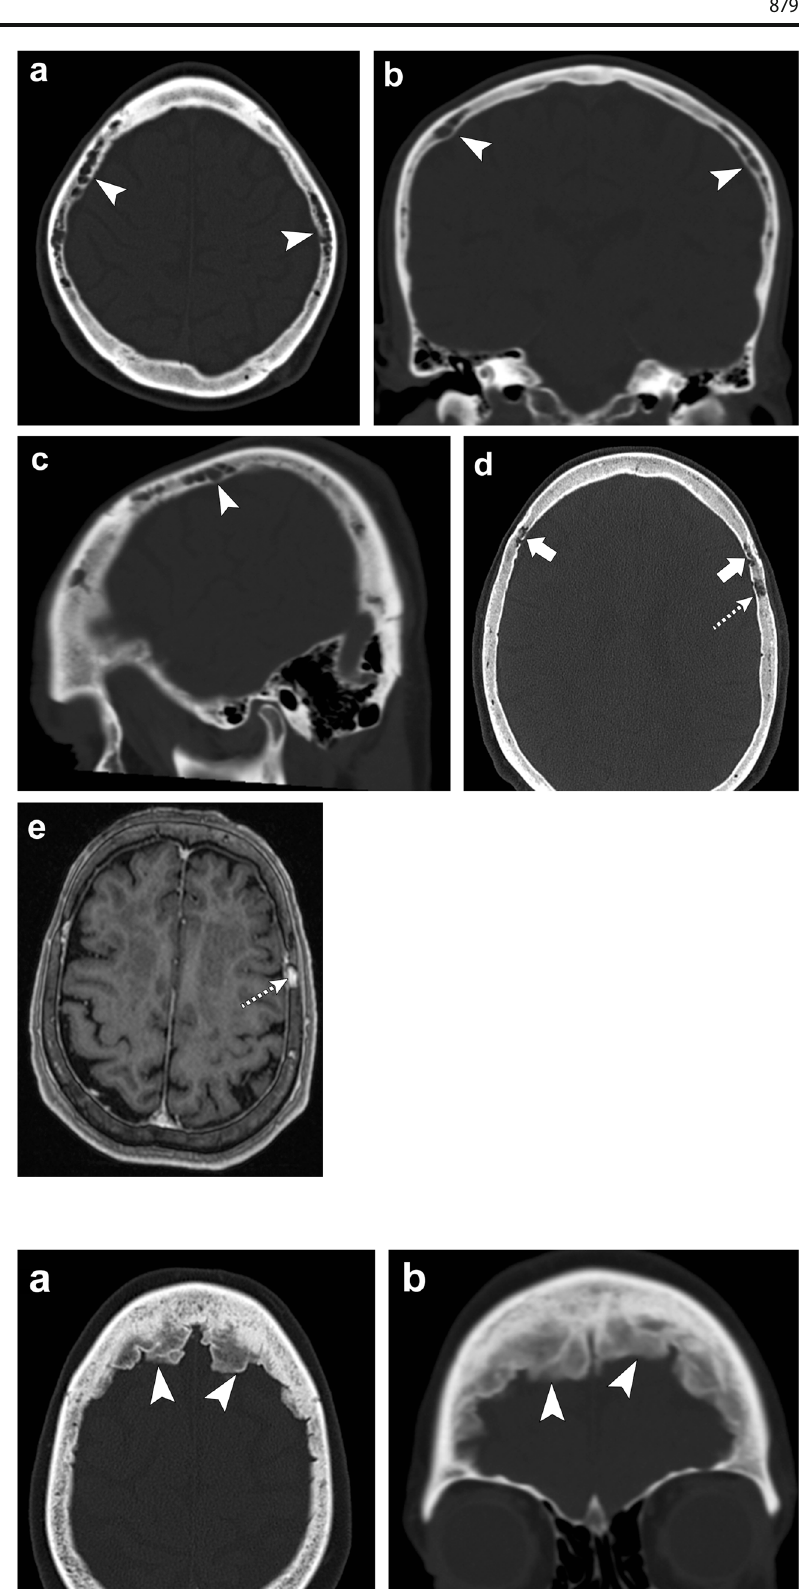
Fig. 24 Venous channels and lakes. Axial ( a ), coronal ( b ) and sagittal ( c ) head CTimages depict serpiginous structures in the frontal and parietal bones ( arrowheads ) representing prominent venous channels.